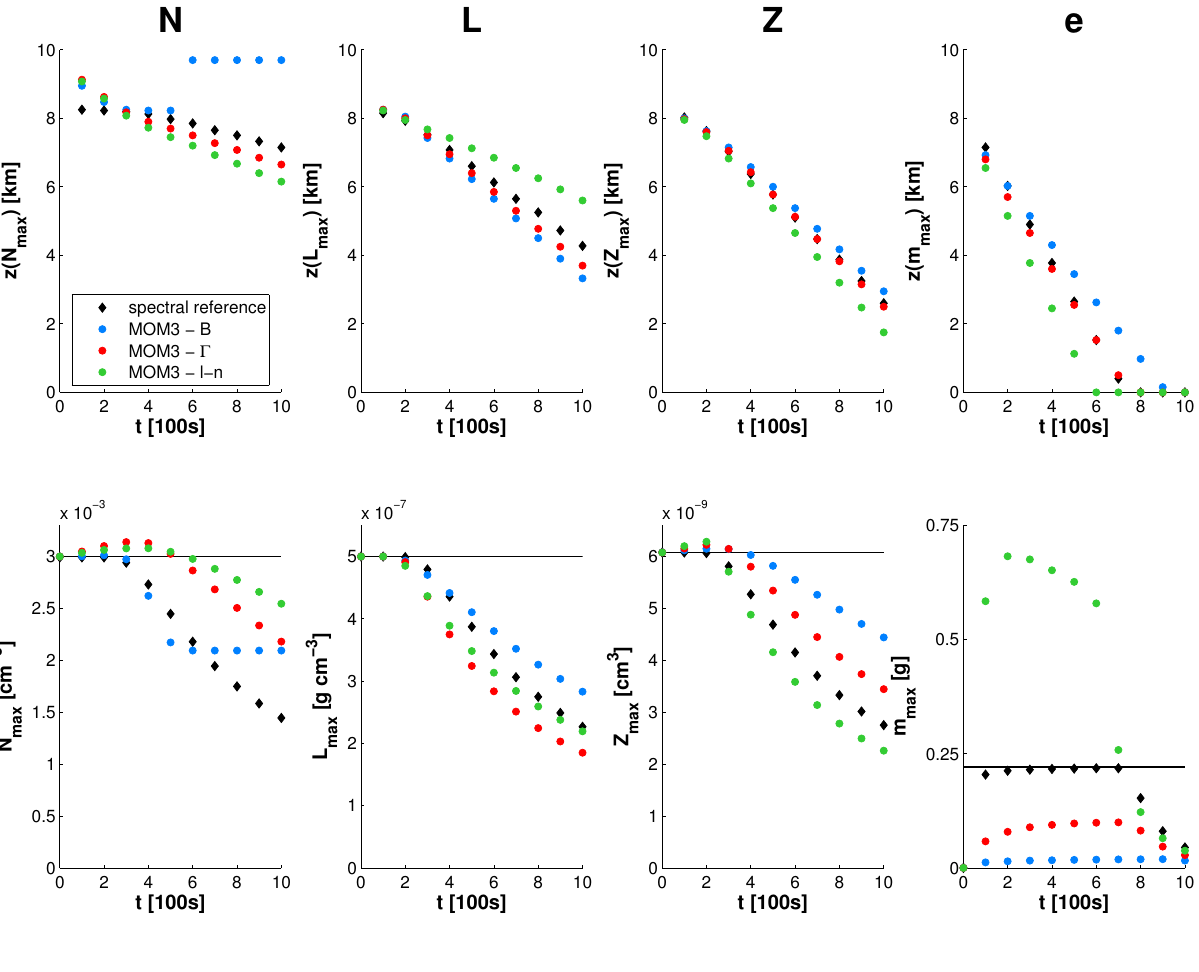
Figure 5. BOX case: maximum values (bottom) and corresponding heights (top) of N , L , Z and m for the reference (black) and the MOM3 models (color coding as in Figures 2 and 3). For the thin black line in the bottom row, see the text.